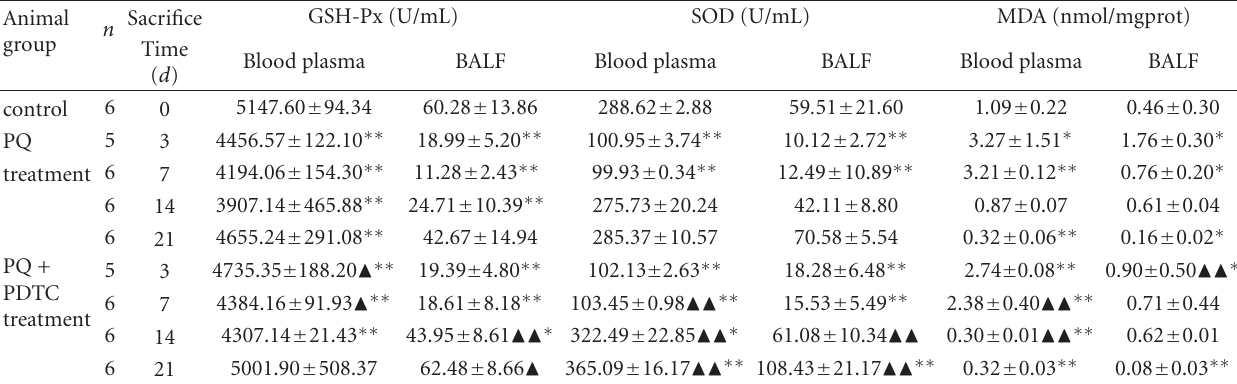
Table 1: Comparisons of GSH-Px, SOD, and MDA among groups of PQ treatment, PQ+PDTC treatment, and the control (Mean ± SE). Animal